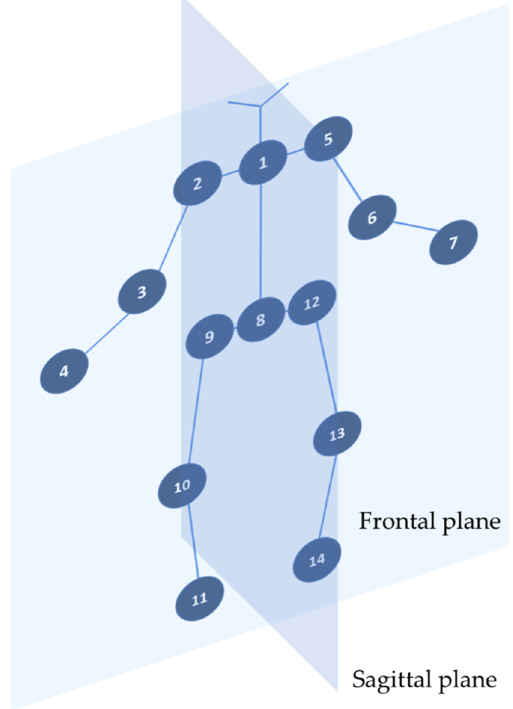
Figure 3. Skeleton model and keypoints used for joint measurements: left shoulder flexion: 1-5-6 (sagittal plane); right shoulder flexion: 1-2-3 (sagittal plane); left shoulder abduction: 1-5-6 (frontal plane); right shoulder abduction 1-2-3 (frontal plane); left elbow flexion: 5-6-7 (sagittal plane); right elbow flexion: 2-3-4 (sagittal plane); left knee extension: 12-13-14 (sagittal plane); right knee extension: 9-10-11 (sagittal plane).